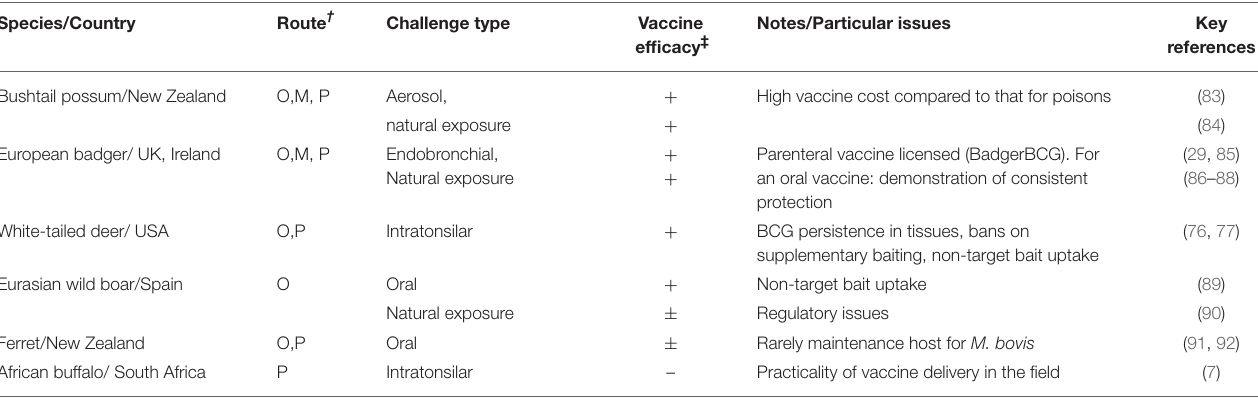
TABLE 3 | Summary of BCG vaccine efficacy studies in